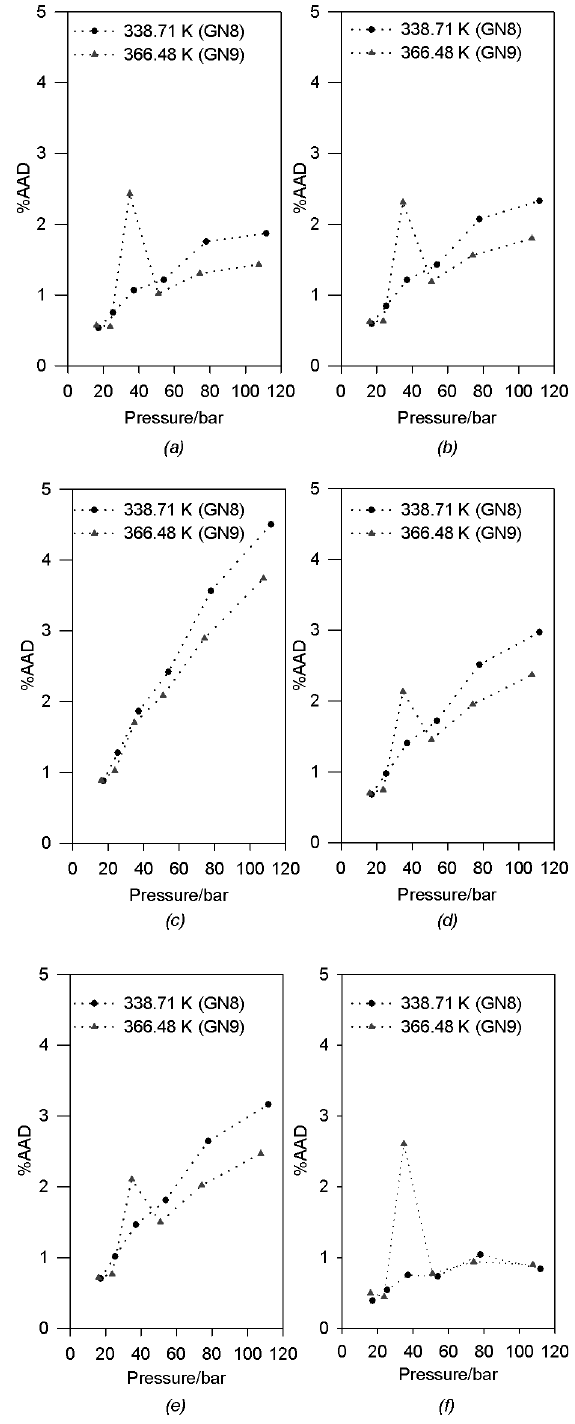
Figure 3. Volume deviations (%AAD) of mixtures GN8 and GN9, calculated with the models PR with non-zero BIPs (a), Coquelet (b), Saffari-Zahedi (c), Mathias- Copeman (d), Gasem (e) and extended Saffari-Zahedi